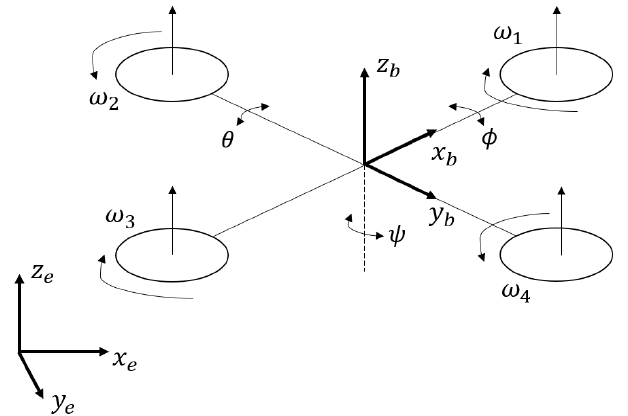
Figure 1. The theoretical model of